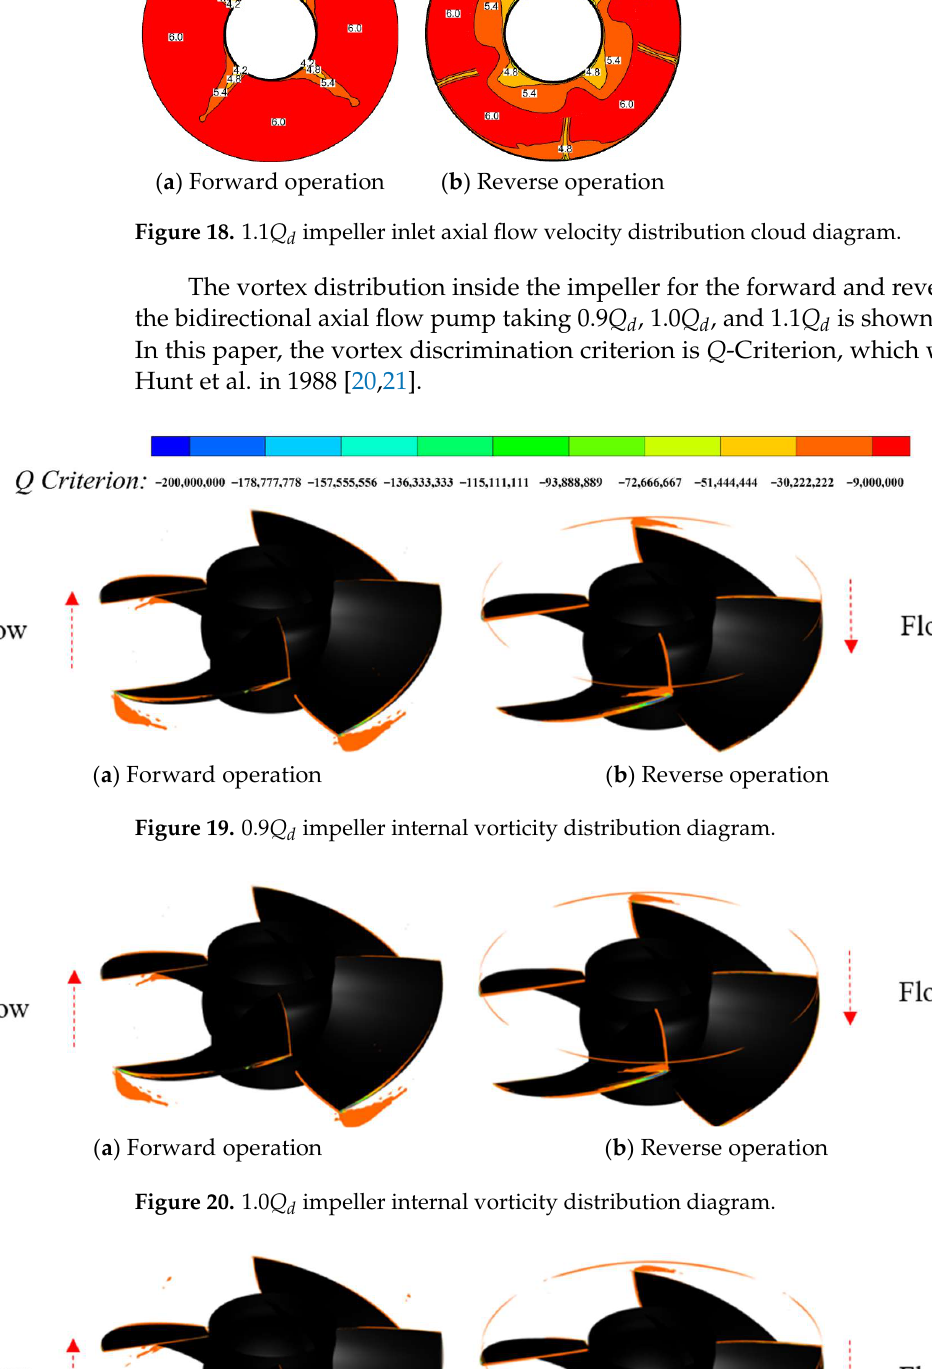
Figure 17. 1.0 Q d impeller inlet axial flow velocity distribution cloud diagram.